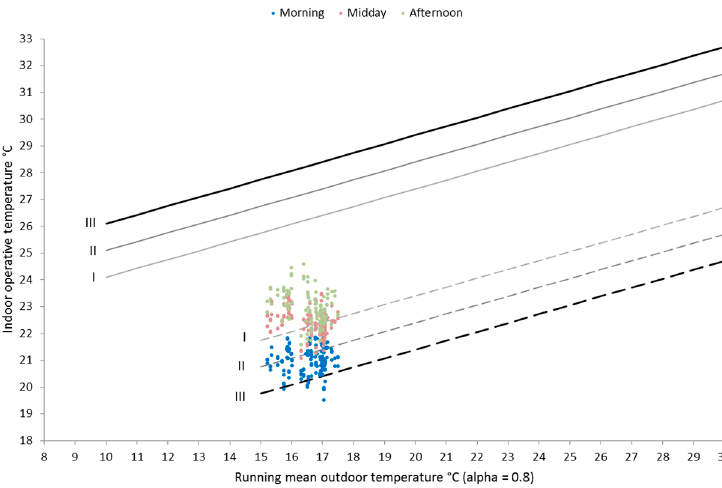
Figure 12. Acceptable operative temperature ranges from the adaptive comfort model included in CEN Standard EN15251. The colored dots represent indoor operative temperatures registered during office hours (morning: 8:00–10:00 a.m.; midday: 12:00–2:00 p.m.; afternoon: 4:00–5:00 p.m.).